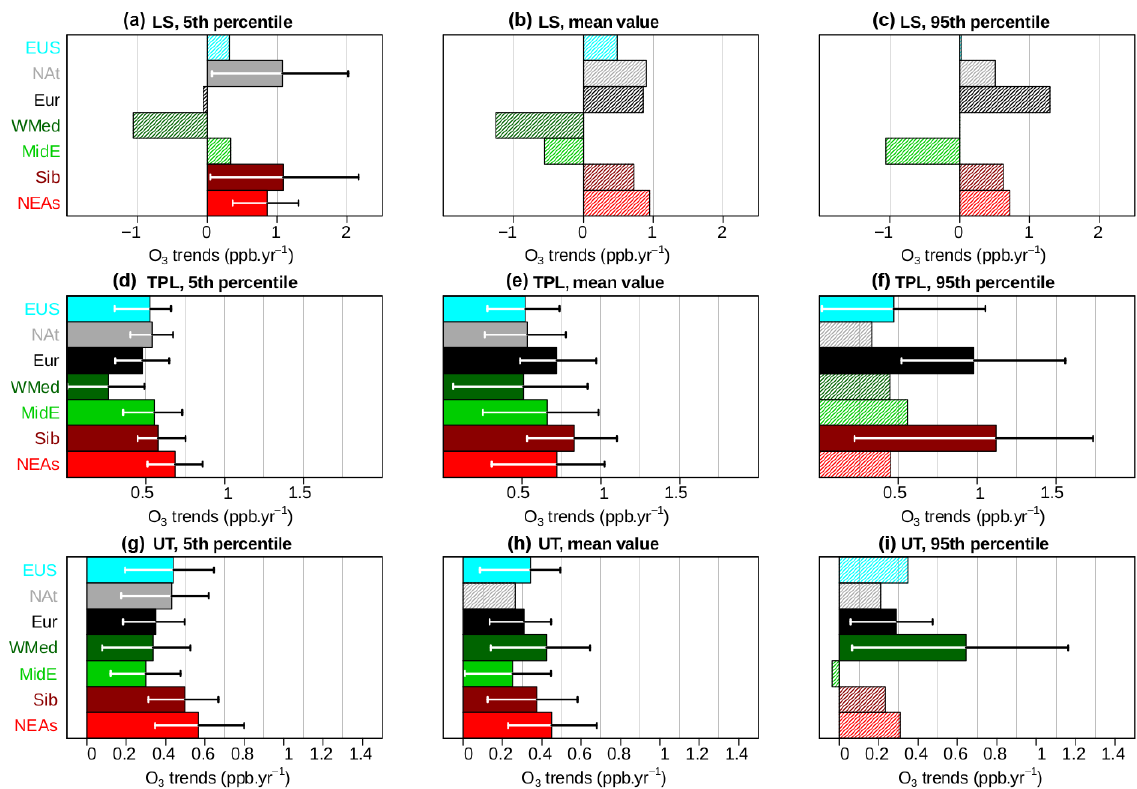
Figure 10. O 3 trends (ppbyr − 1 ) in the UT, TPL, and LS (from bottom to top) for the monthly 5th percentile (a, d, g) , mean value (b, e, h) , and 95th percentile (c, f, i) . For each significant trend, the error bars represent the 95% confidence interval. The insignificant trends are represented by hatched areas. The coloured labels correspond to the regions defined in Fig.